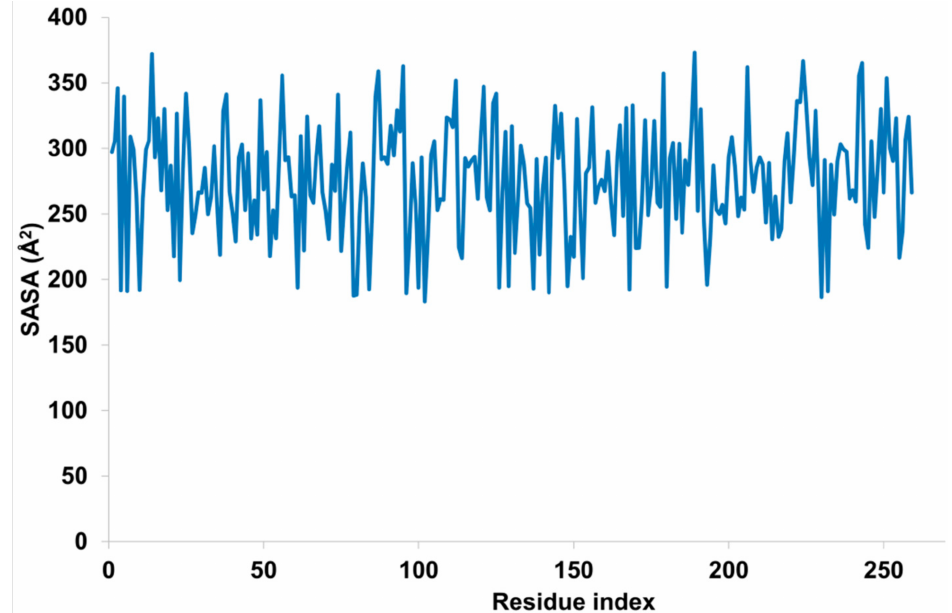
Figure 11. Residue-wise solvent accessible surface area of CA-II.